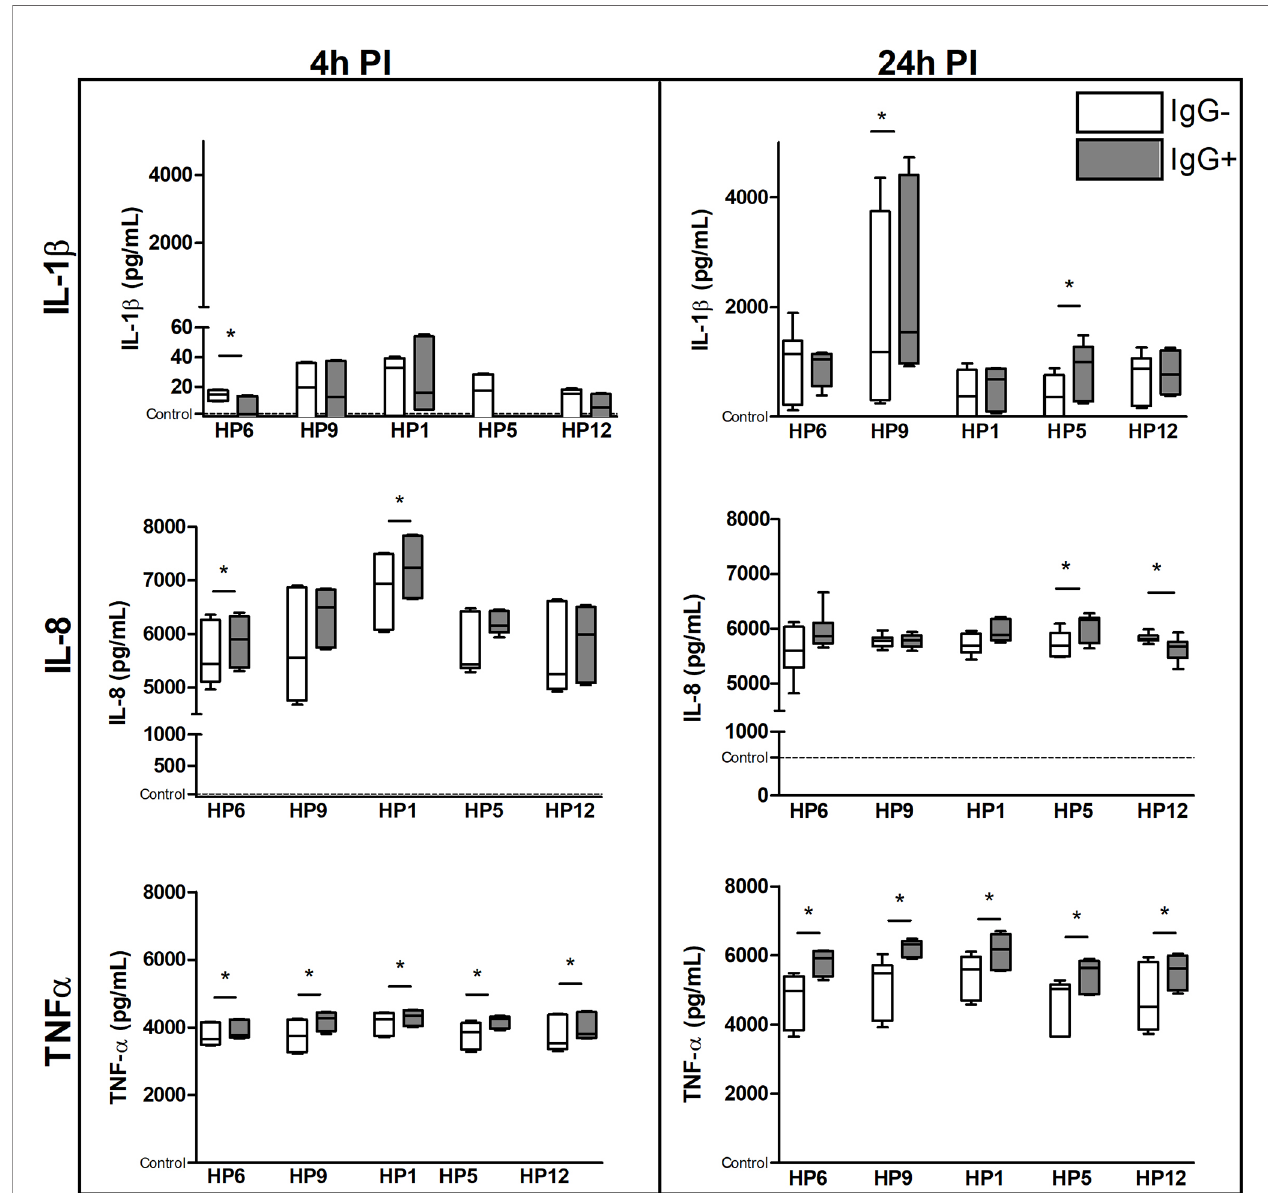
FIGURE 9 | The immune response of PAMs at a protein level. PAMs were infected with various G. parasuis strains for 4 and 24 h. The concentration of IL-1 b , IL-8 and TNF- a was measured by commercial ELISA kits at these PI times. Signi fi cant difference between groups with (IgG+) or without (IgG-) the post-vaccinal IgG is denoted by asterisk (p<0.05).Dotted line displays expression of mRNA in the control non-infected